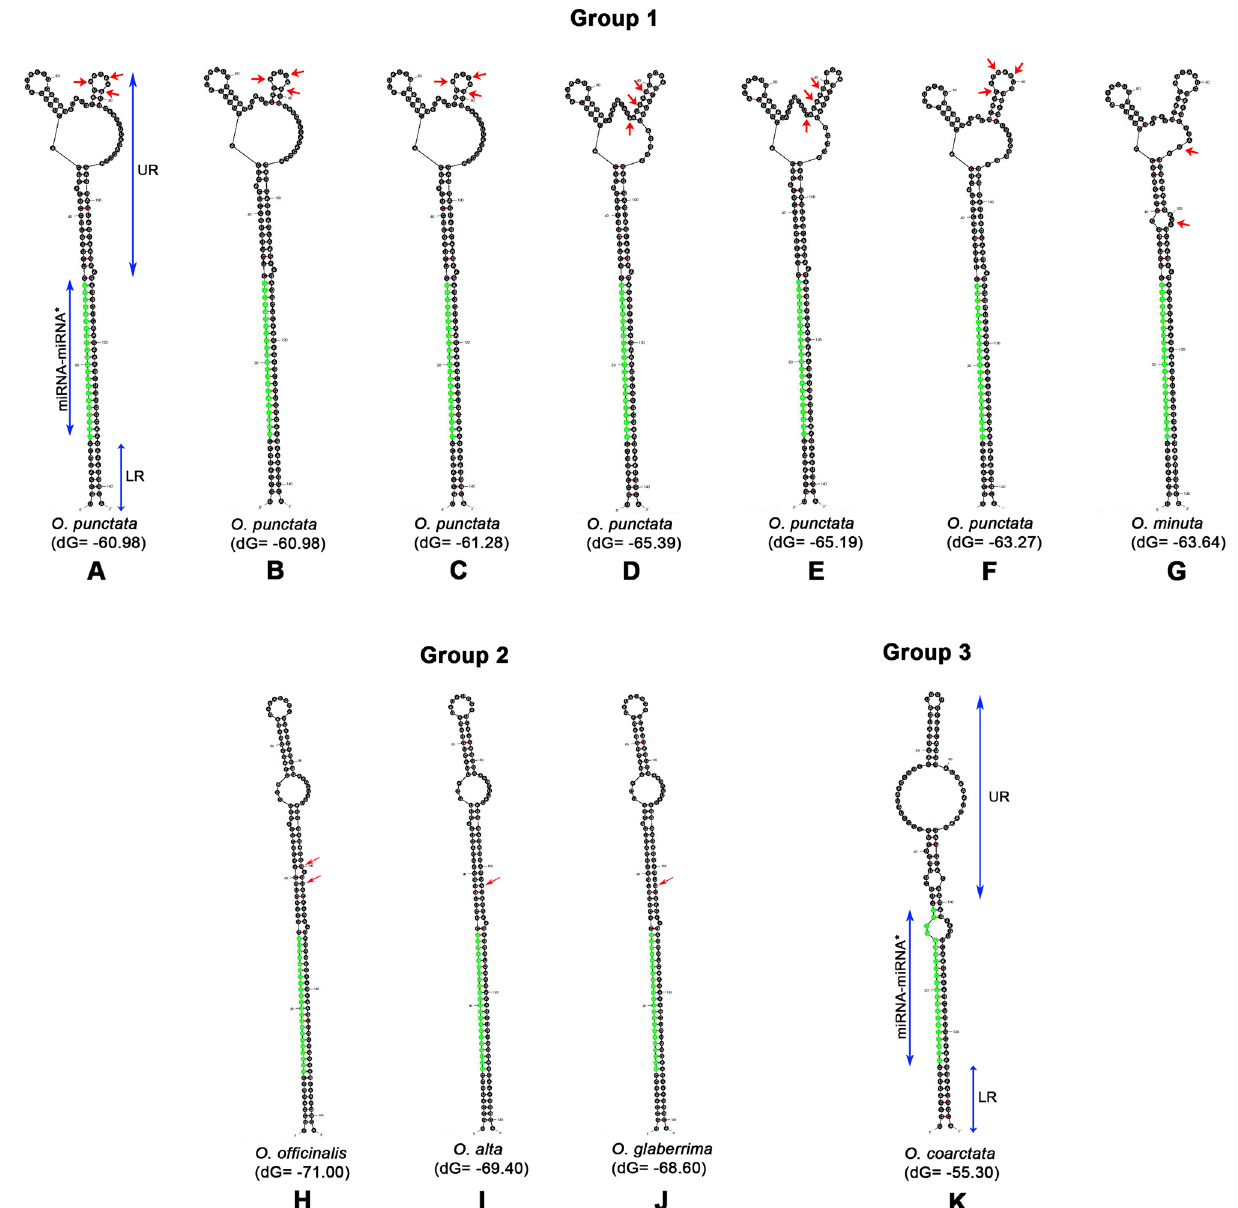
Figure 2. Predicted secondary structures for pre- miR396c using Mfold. Pre- miR396c structures from twelve Oryza species can be divided into three groups. Three elements are absolutely conserved across eleven Oryza spp . Pre- miR396c structures: (i) miRNA-miRNA* duplex (miRNA in green)(ii) a five bp bulge above the miRNA-miRNA* region (indicated by a grey box) (iii) 9 bp lower conserved region (LR) below the miRNA- miRNA* duplex (of which 6 bases show pairing). ( A – G ) : Group I contains pre- miR396c structures from O. punctata (142 bases) and O. minuta (141 bases). O. punctata pre-miRNA 396c sequence shows heterozygosity at positions 74 and 79 (M = A or C) in addition to insertion of a single base at position 102 (indicated by red arrows; Fig. 2-1). ( H – J ) : Group II contains . officinalis , O. alta and O . glaberrima pre- miR396c structures differing only in an ‘A’ or ‘G’ at the 103 position of the pre- miR396c sequence (Fig. 2-2). ( K ) : Group 3 contains only O . coarctata pre- miR396c . The miRNA-miRNA* duplex region is indicated in green and perfect pairing is disrupted due to 6